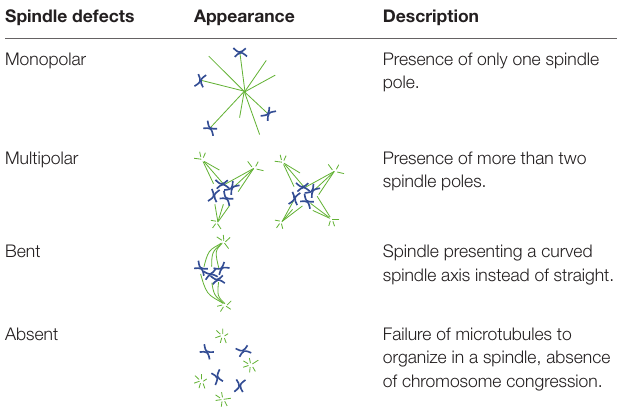
TABLE 1 | Diagrammatic representations and descriptions of all spindle abnormalities documented in the present study.